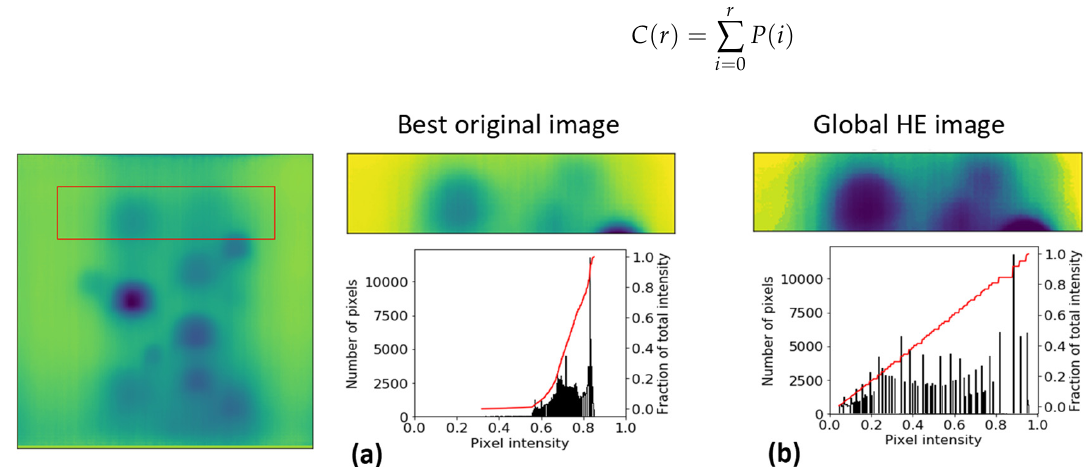
Figure 6. Comparison of the original image and globally equalised histogram image and their histogram (black) and cumulative distribution function (red) for a selected area of the test surface ( a , b ) [2], reproduced with permission from authors own work, Sub-surface metal loss defect detection using cold thermography and dynamic reference reconstruction (DRR). Structural Health Monitoring, 2021: p. 1475921721999599.